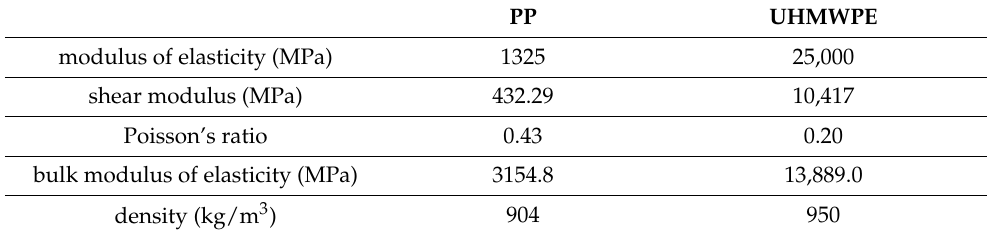
Table 1. Properties of PP and UHMWPE used in the current